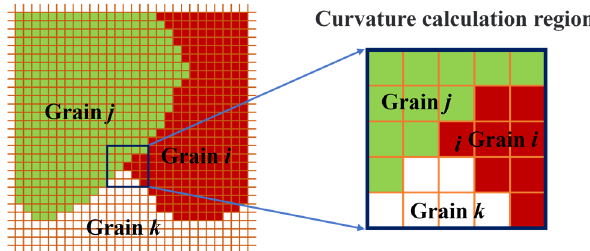
Figure 1. Schematic view of local GB curvature calculation.